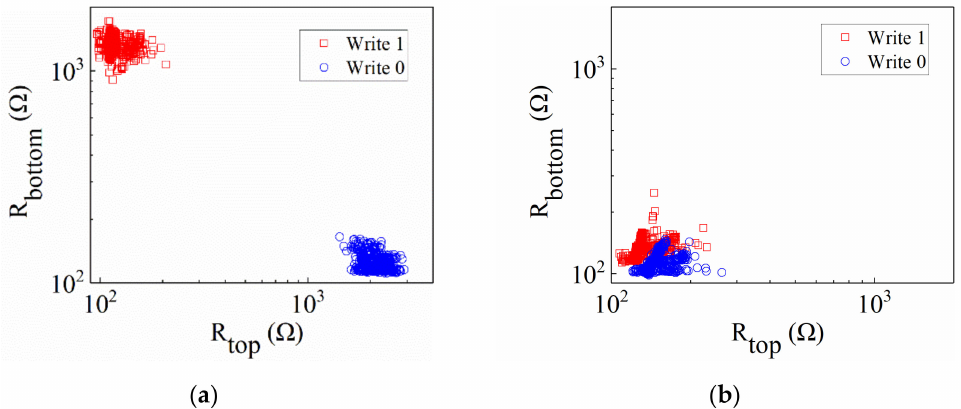
Figure 17. RRAM resistances of a serial cell during a sequence of 1000 write-unmasking-masking cycles with random Scheme 0. operation: ( a ) After unmasking; ( b ) After